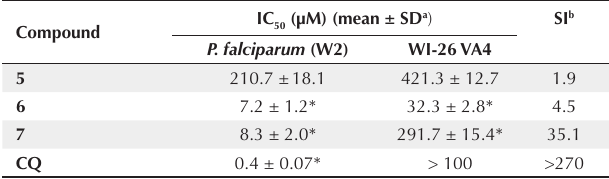
Table 1 . In Vitro Antiplasmodial Activities, Cytotoxicities, and Selectivity Indices of Chloroquine and Compounds 5 , 6 , and 7